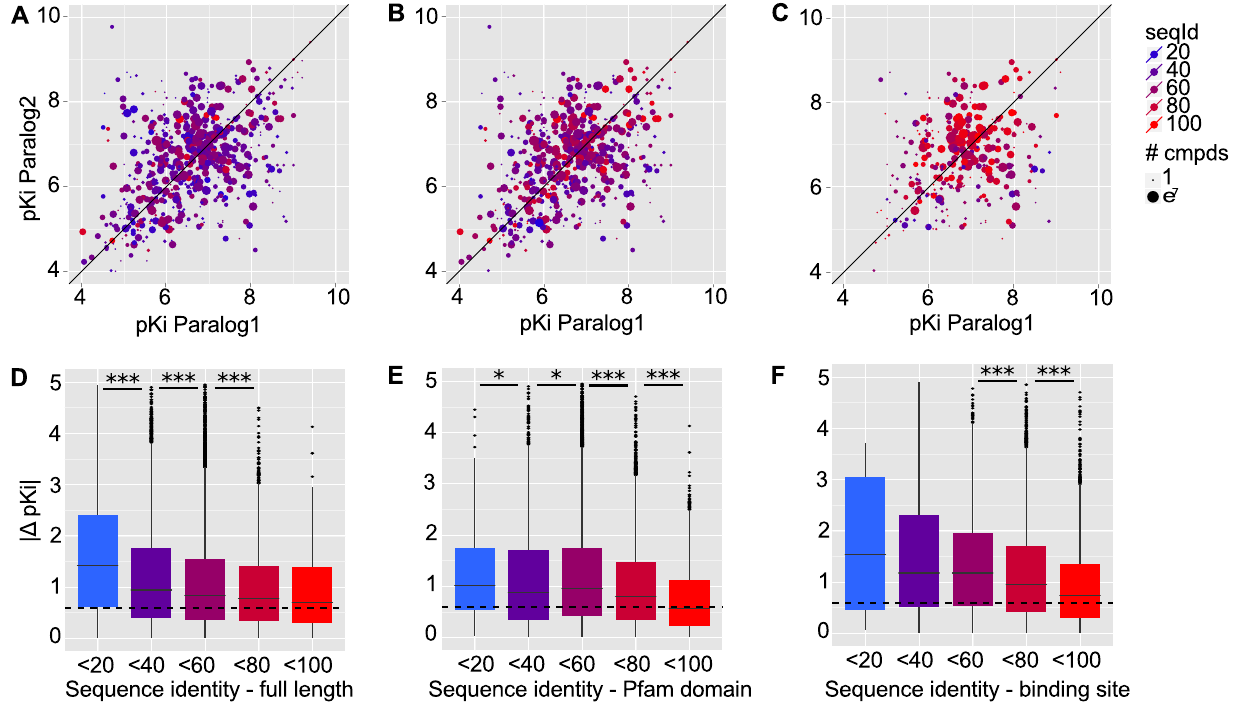
Figure 3. Differences in small molecule binding for human paralogs. Sequence identity was measured on three levels: (a,d) Full sequence, (b,e) sequence of the domain containing the binding site and (c,f) residues of GPCR and kinase binding sites. Scatter plots of binding affinities measured against pairs of human paralogs are shown in the top row. Points represent median affinities of all compounds measured against a given combination of targets. Box plots in the bottom row represent the distribution of measured differences in binding affinity for pairs of targets having